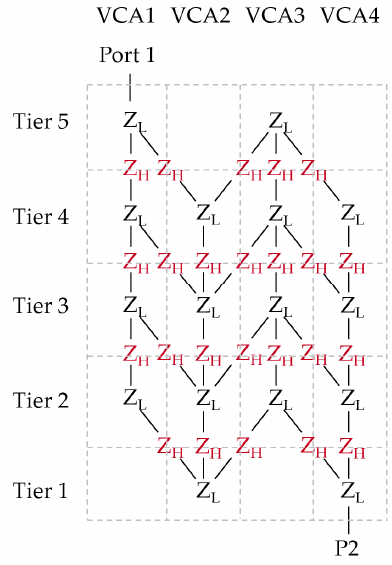
Figure 3. A lattice diagram of the characteristic impedance of the CMS-EBG structure.